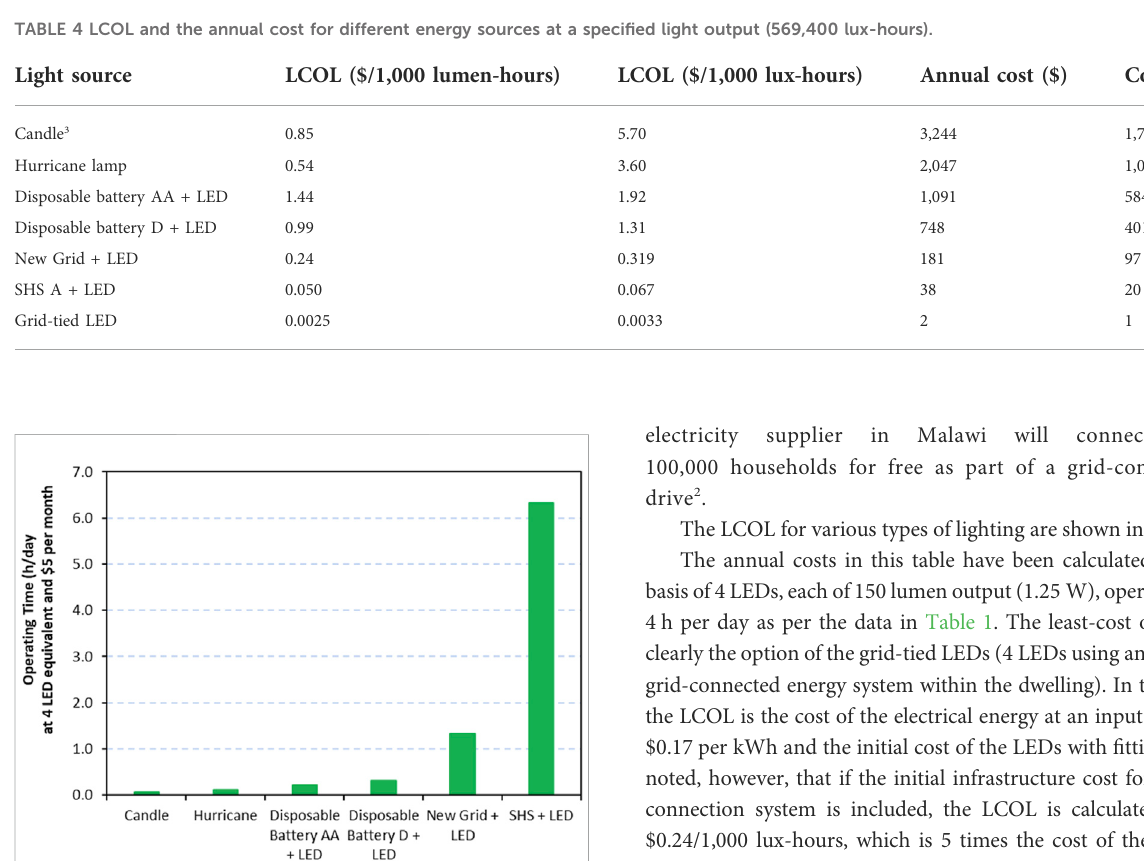
FIGURE 2 Operating time on a $60 per year-budget for different light